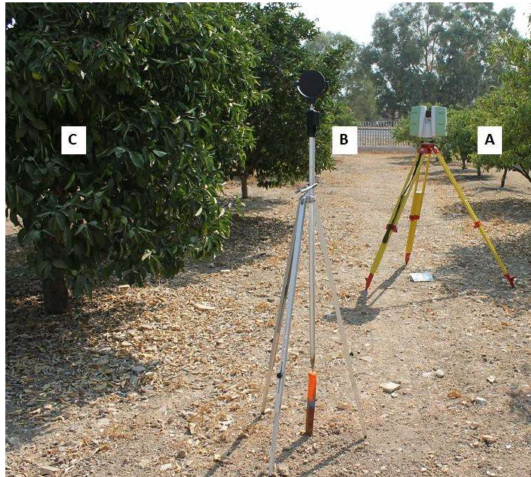
Figure 9. High definition survey (HDS) in the trial. ( A ) HDS Station. ( B ) Ranging rod and tripods placed on the stakes. ( C ) Orange Trees.